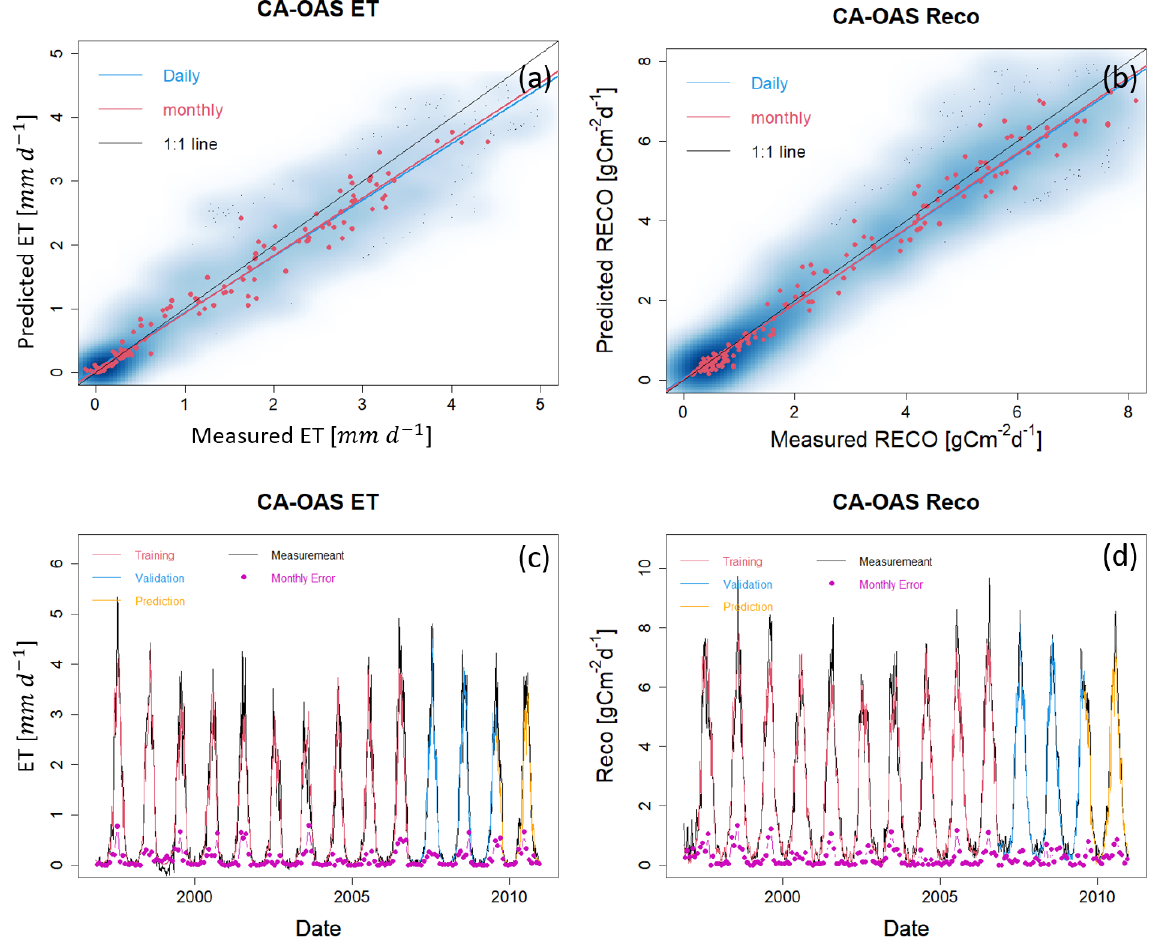
Figure 5. ET and R eco estimation with data from FLUXNET sites at CA-OAS. Panels (a) and (b) show the scatter plots of daily (blue) and monthly (red) ET and R eco between HPM estimation and FLUXNET data. Darker blue clouds represent greater density of data points. Panels (c) and (d) present the daily HPM estimation of ET and R eco separated by training, validation and prediction sets. Pink points depict monthly error between HPM estimation and FLUXNET data. Results for other sites are included in the Appendices below (Figs. A1, A2, A3, and A4). Table 3. Statistical measures of HPM estimation of ET and R eco